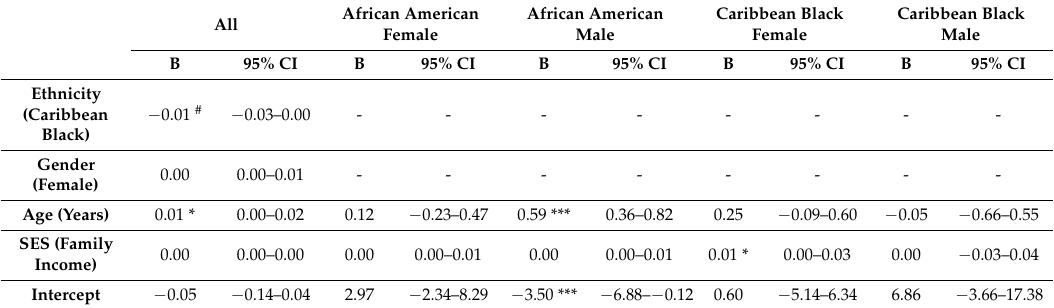
Table 2. Summary of linear regression on the effects of family income on perceived discrimination.